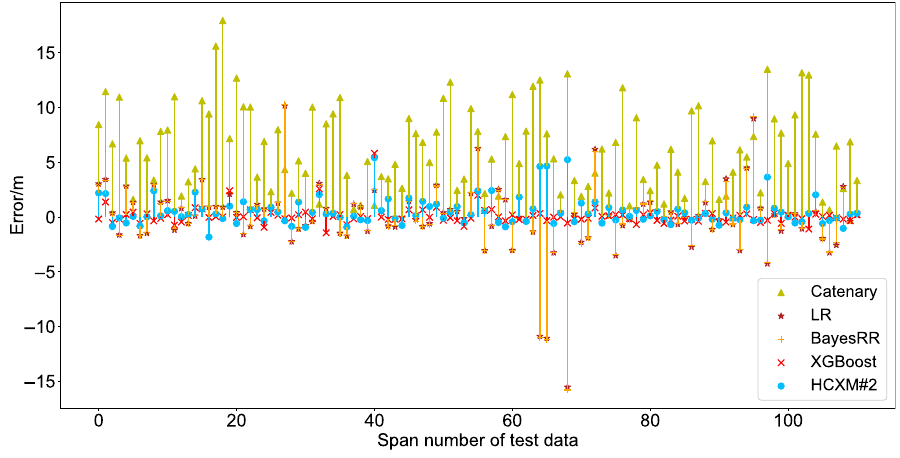
Figure 17. Sag estimation errors of cluster #2.